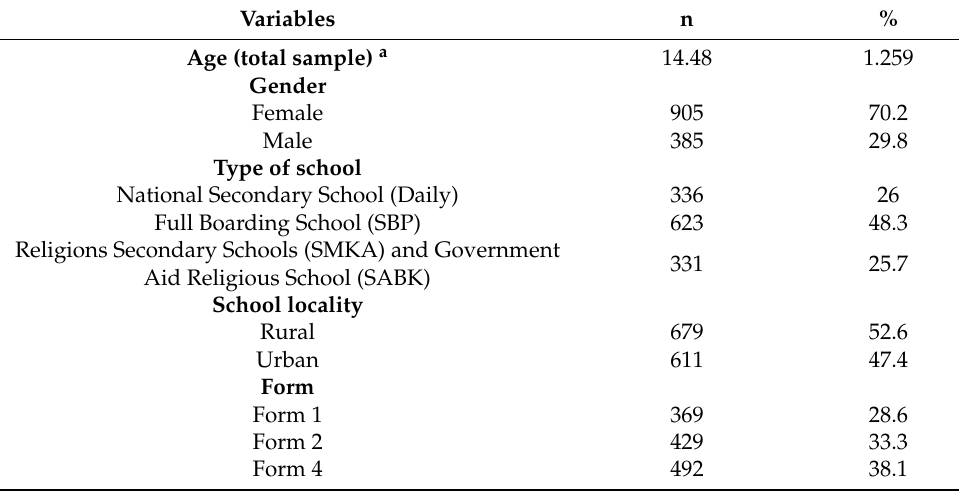
Table 1. Sociodemographic and other characteristics of the respondents (n =